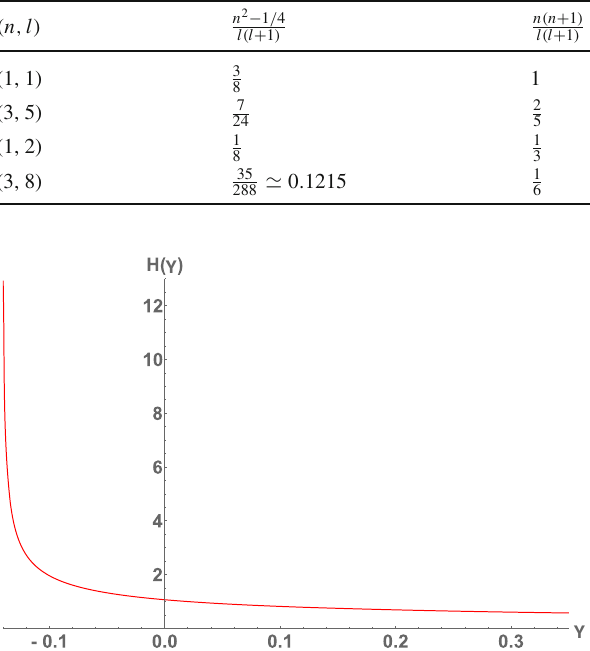
H is then being calculated along the near-extremal locus in Fig. 1a, b. The values of H of extremal BHs are covered by the range of H obtained along the near-extremal